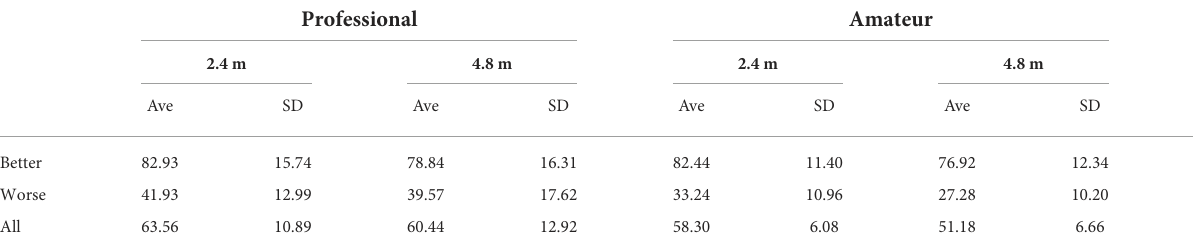
TABLE 2 Statistics of subjective putting